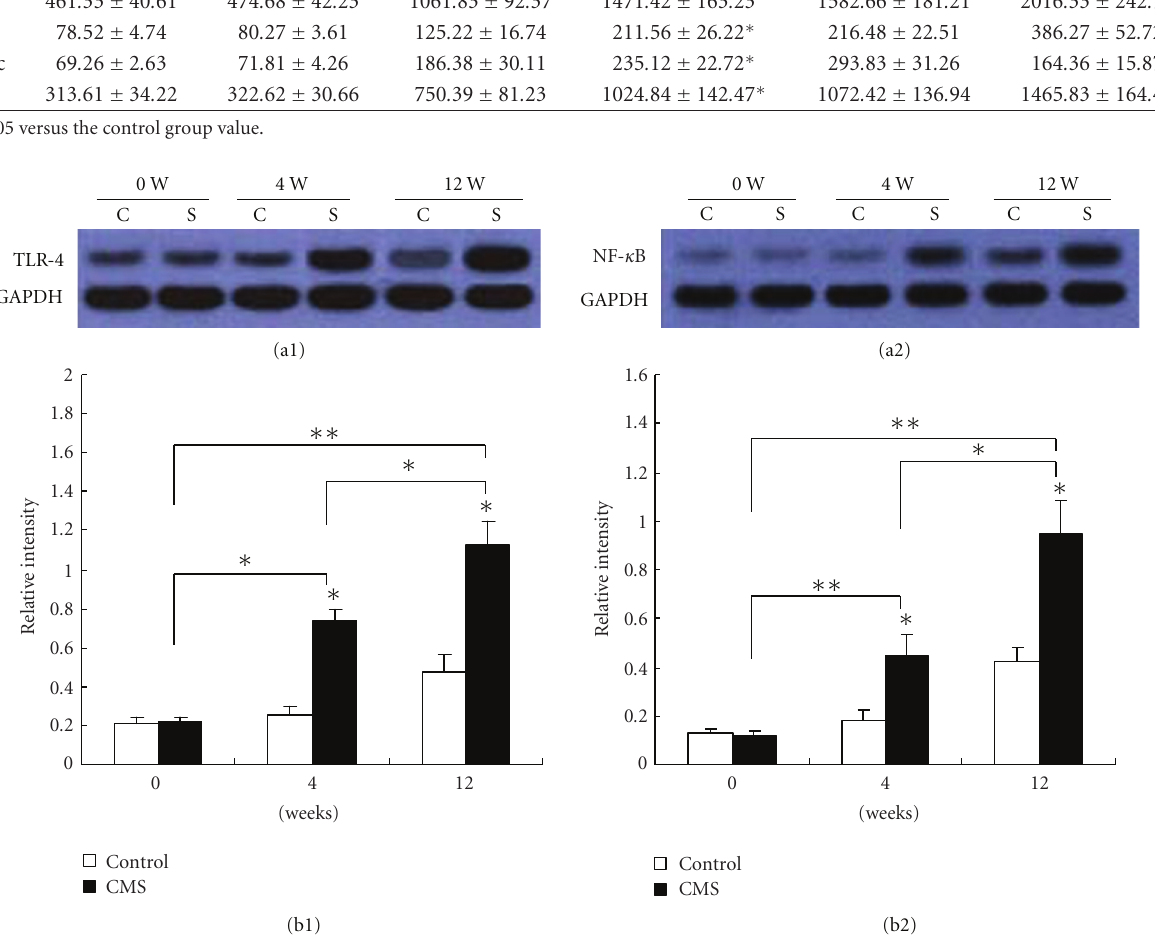
Figure 6: Validation of changes in TLR-4 (73 KD) and NF- κ B p65 (80kDa) protein expression by western blotting. Proteins extracted were prepared from arteries ( n = 6) of mice subjected to CMS or normal conditions for 0, 4, and 12 weeks, respectively. Each lane shows representative western blots using anti-TLR4 or NF- κ B p65 and anti-GAPDH bodies in (a1) and (a2), respectively. Each panel summarizes densitometric readings of band intensities normalized to GAPDH, which was measured by densitometry with Image J image analysis software. (b1), (b2) densitometric measurements TLR4 and NF- κ B p65 from Western blots, respectively. Data are mean ± SEM. C: control group; S: chronic mild stress group ( n = 6 per group). ∗ P < . 05, ∗∗ P < . 01 compared with the control. The data are representative of three